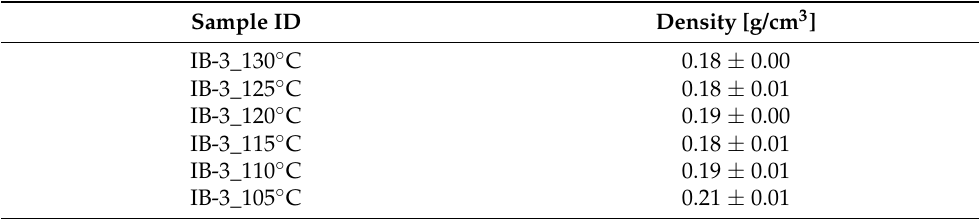
Table 4. The densities of prepared cellulose palmitate foams using different foaming temperatures and 3% IB as a blowing